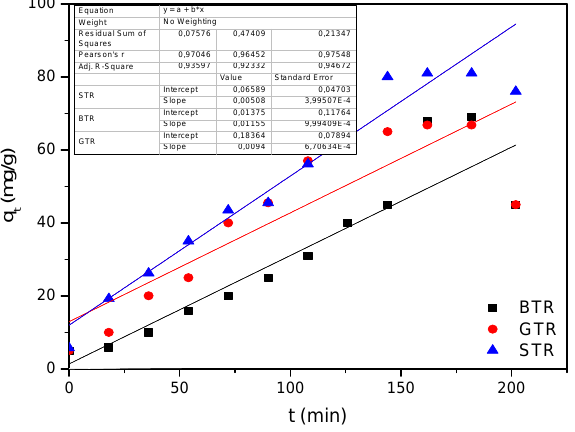
Figure 6. Plot of the equilibrium quantity of Pb 2 + adsorbed with response to time by the three resins. Table 3. The kinetics constants for the adsorption of Pb 2+ (Resin: 0.5 g/L; C i : 100 ppm; particle size + 100 µ m; temperature: 303 K; agitation rate: 120 rpm; contact time: 180 min; pH